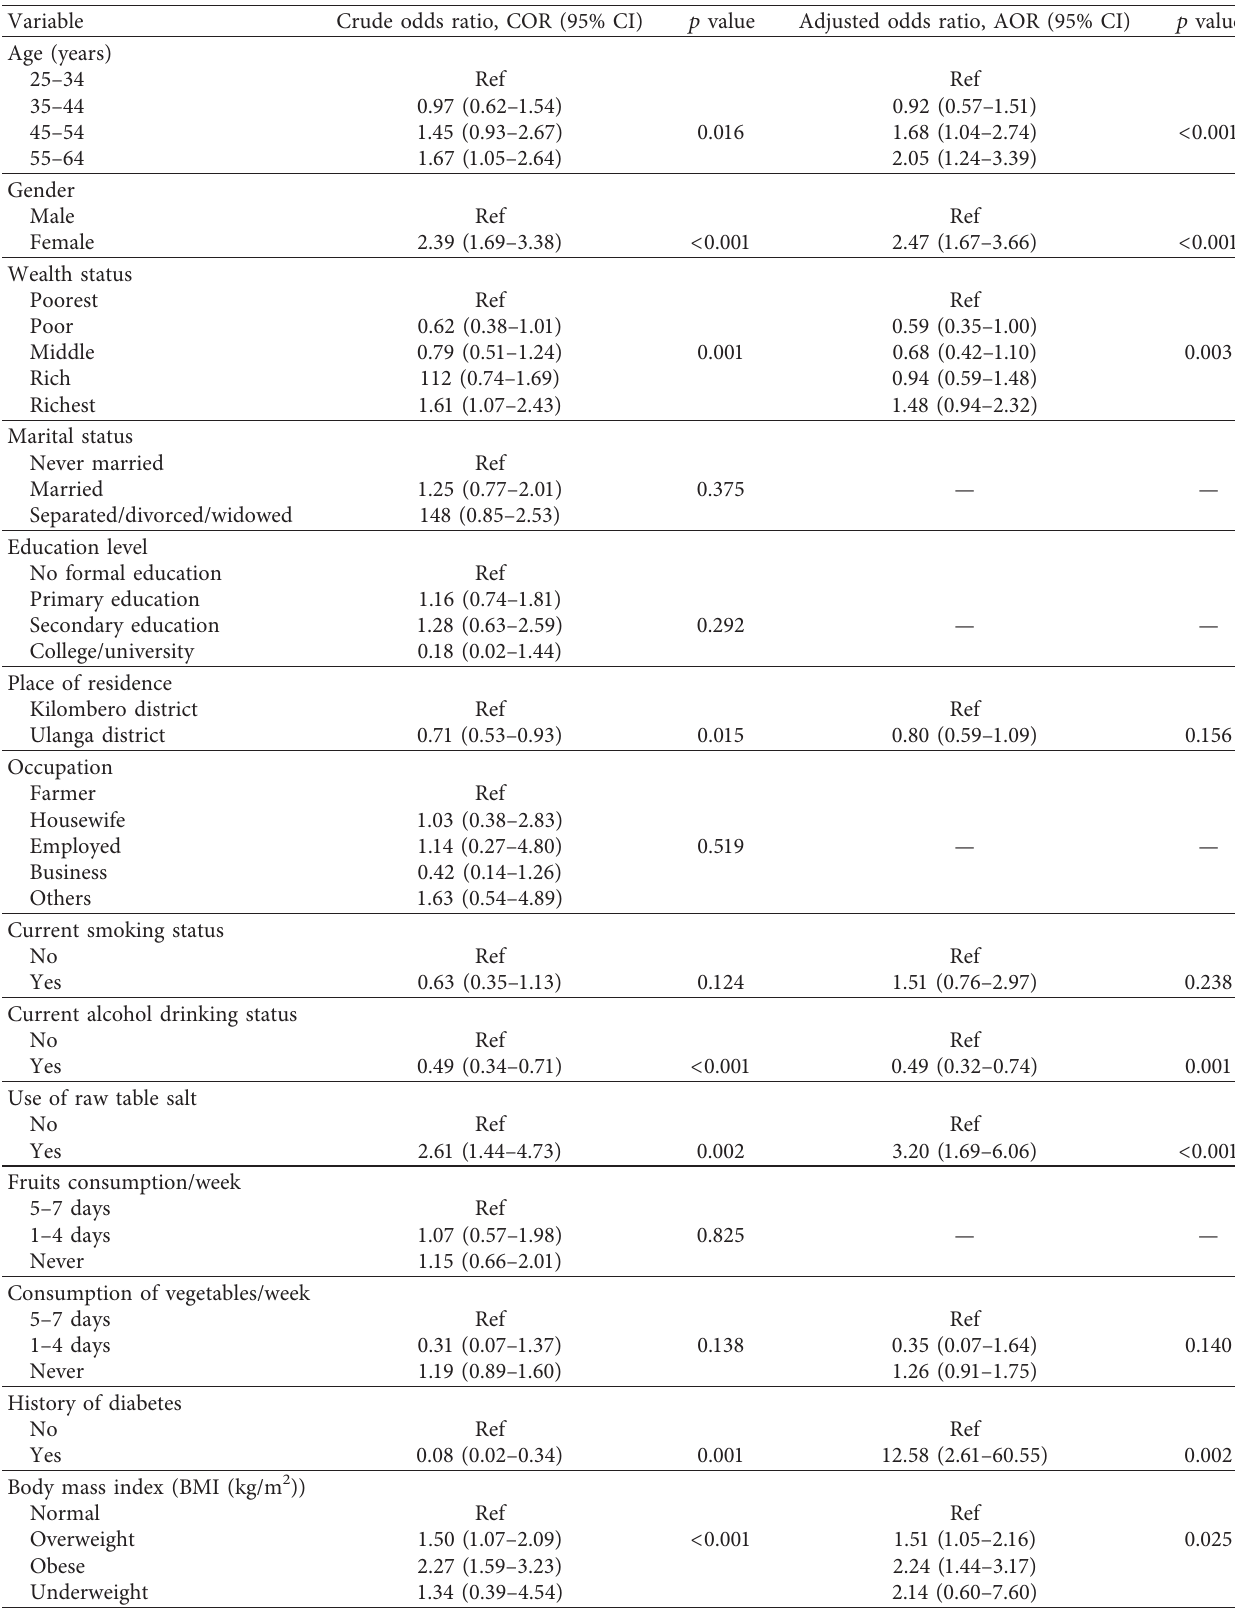
Table 4: Crude and multivariate adjusted logistic regression models for determinants of awareness of hypertension status among hy- pertensive individuals ( N �